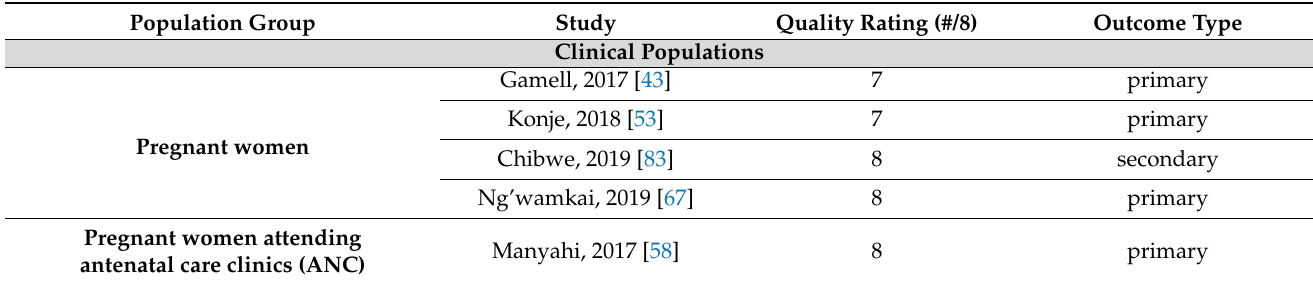
Table A2. Quality assessment of included studies organized by clinical and nonclinical population groups. Quality results are discussed in Sections 3.2.1 and